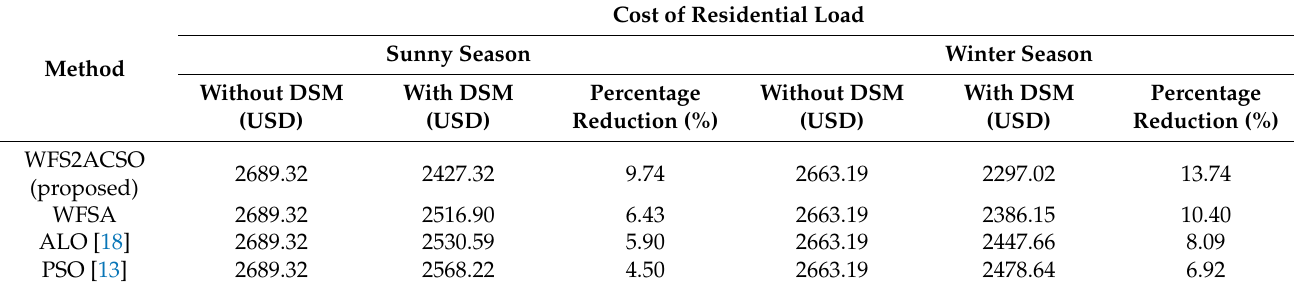
Table 6. Comparison of percentage cost reduction for different optimization methods for residential load.